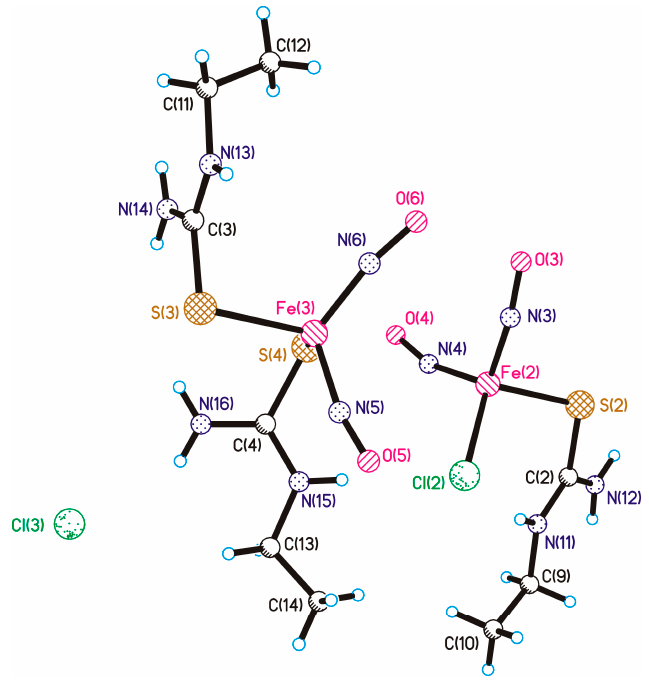
Figure 1. Molecular structure of ETM with the atomic numbering scheme.